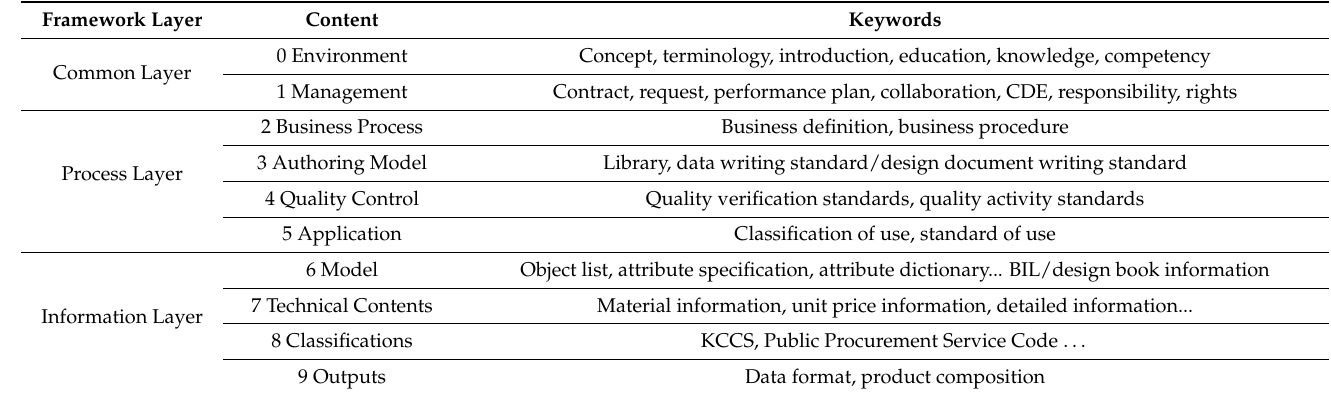
Table 6. Components of the BIM information standard framework layer.